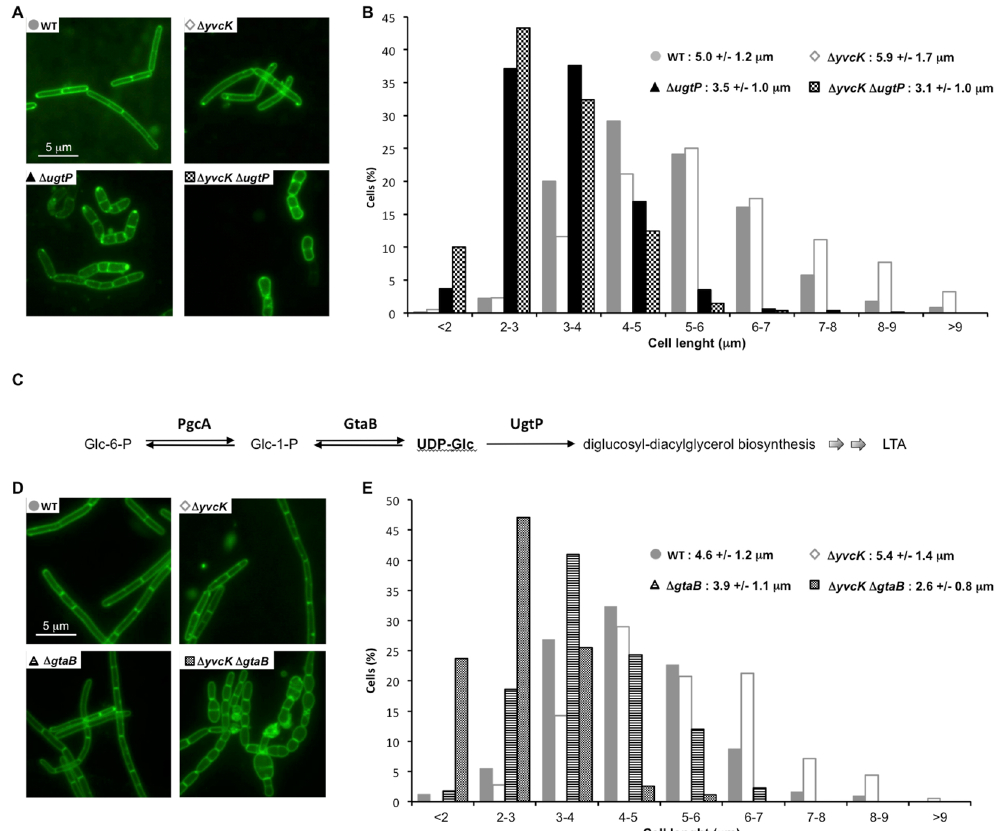
Figure 3. A yvcK deletion enhances the effect of deletions of ugtP and gtaB genes. Strains were grown on LB medium until OD 600 = 0.4. ( A ) Micrographs of WT strain (168) and mutant strains Δ yvcK strain (SG471), Δ ugtP strain (SG571), Δ ugtP Δ yvcK strain (SG561). Membranes were stained with FM1-43. ( B ) Histogram of cell lengths for WT strain (n = 1032), Δ yvcK strain (n = 611), Δ ugtP strain (n = 970) and Δ ugtP Δ yvcK strain (n = 626). ( C ) Simplified scheme of the first steps of the glycolipid metabolism. Enzymes involved in this pathways are PgcA: Phosphoglucomutase, GtaB: UTP-glucose-1-phosphate uridylyltransferase, UgtP: Processive diacylglycerol beta-glucosyltransferase. ( D ) Micrographs of WT strain (168) and mutant strains Δ yvcK strain (SG471), Δ gtaB strain (DKE35670), Δ gtaB Δ yvcK strain (SG562). Membranes were stained with FM1-43. E- Histogram of cell lengths for WT strain (n = 390), Δ yvcK strain (n = 183), Δ gtaB strain (n = 355) and Δ gtaB Δ yvcK strain (n =